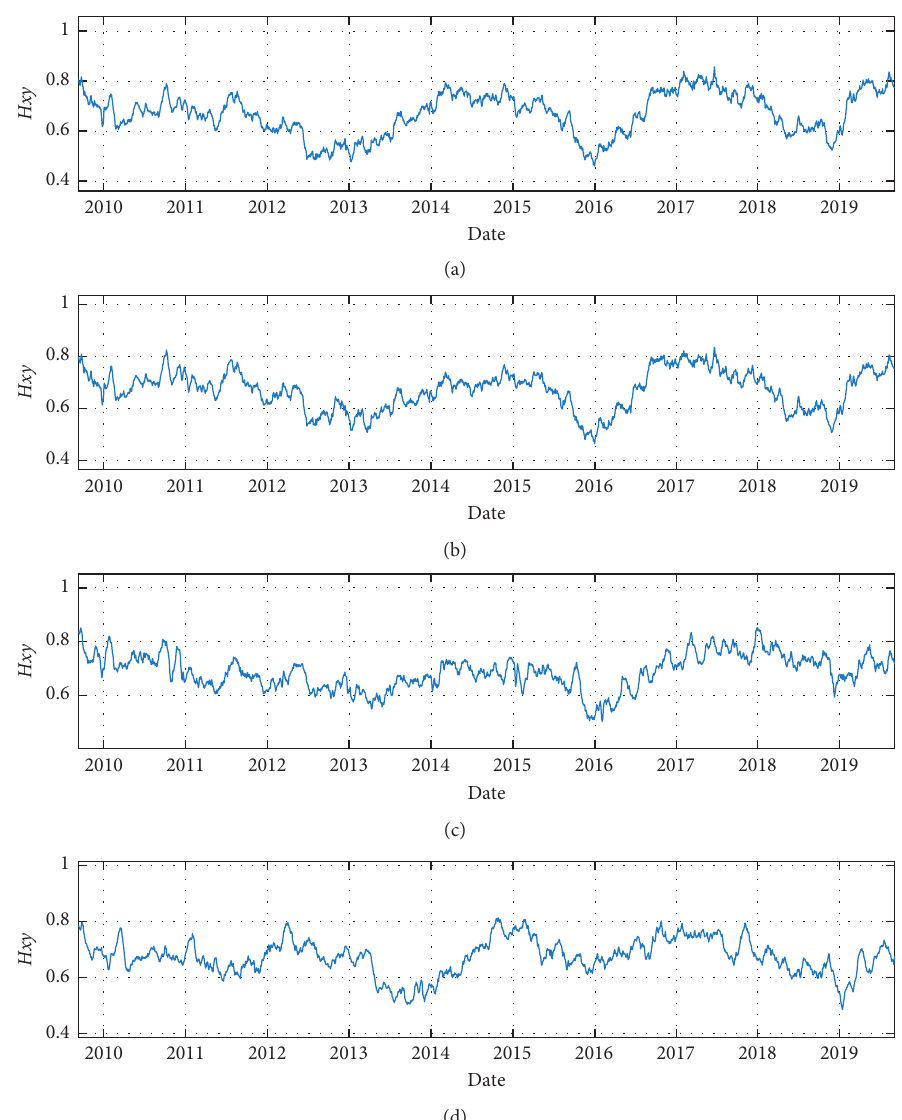
Figure 5: The dynamic evolution of the cross-correlation between financial market return and online sentiment in developed countries ( q � 2): (a) US: SP500, (b) US: Nasdaq, (c) Japan: Nikkei, and (d) Germany: